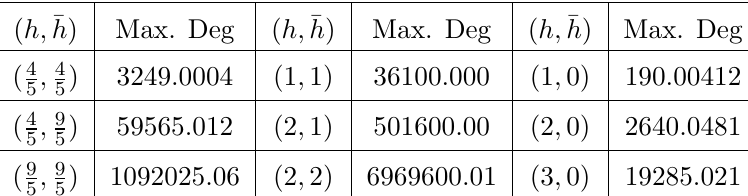
Table 8. The maximum value of degeneracies for low-lying states in a putative CFT at c = 38 For these results, the maximum number of derivative is set to N max = 55, while spin is truncated at j max = 40.